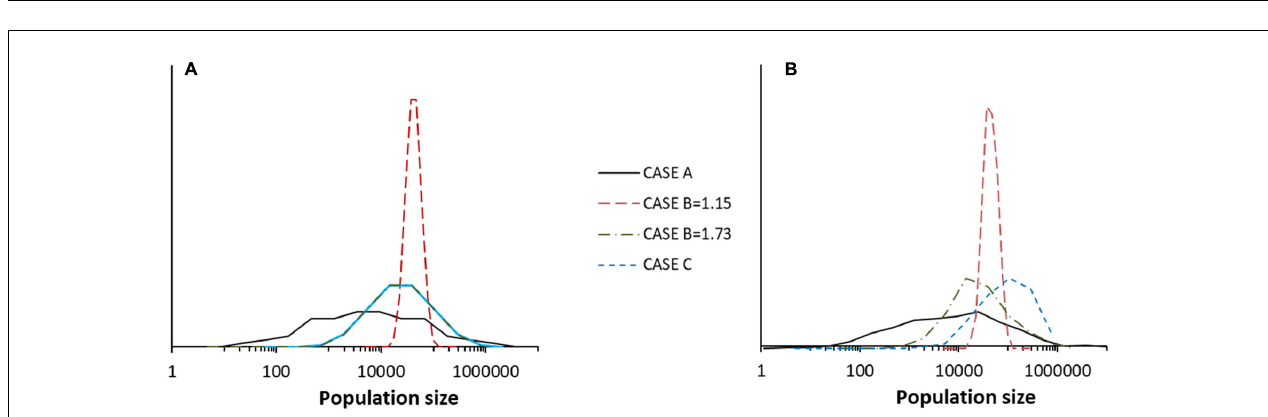
FIGURE 10 | Population dynamics of four randomly chosen species in the community model generated using different distributions with parameters K = 7, with J = 5 × 10 6 for 512 time-steps. (A) Special case B with B = 1.15. (B) Special case B with B = 1.73. (C) Special case A (uniform distribution for U ). (D) Special case C with B = 1.73, with asymmetry q = 0.2. The dynamics are according to Equation (10) without extinction-colonization.